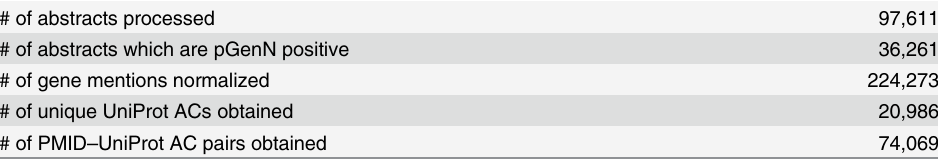
Table 8. Statistics of pGenN processing of gene/protein-related subset of plant Medline abstracts.